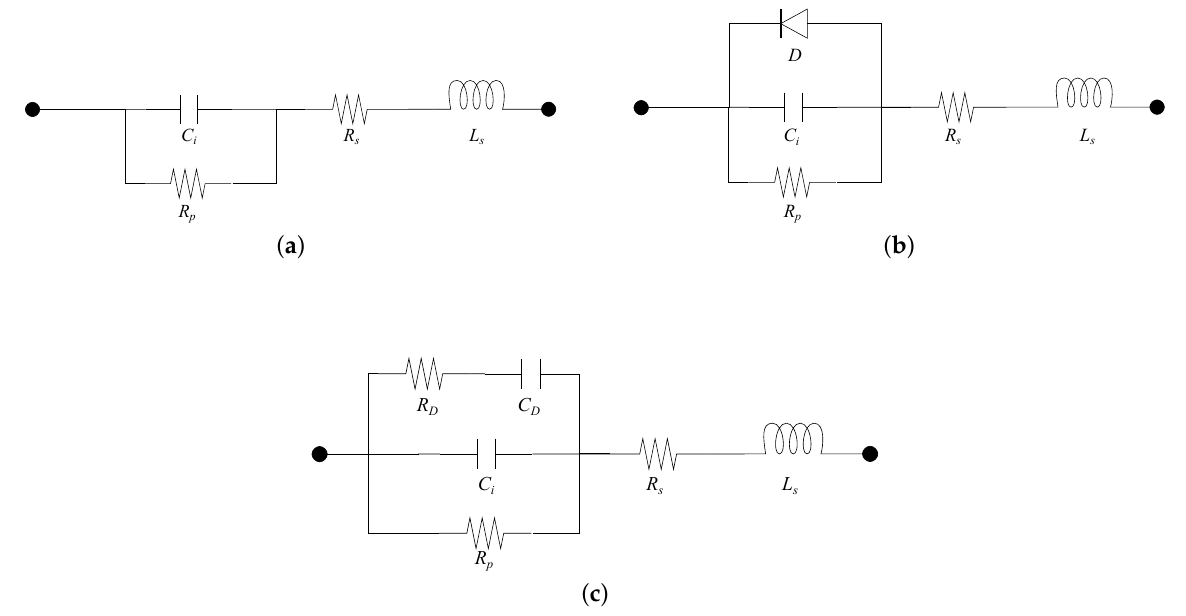
Figure 2. Models of aluminum electrolytic capacitors. ( a ) Model 1 [24]. ( b ) Model 2 [25]. ( c ) Model 3